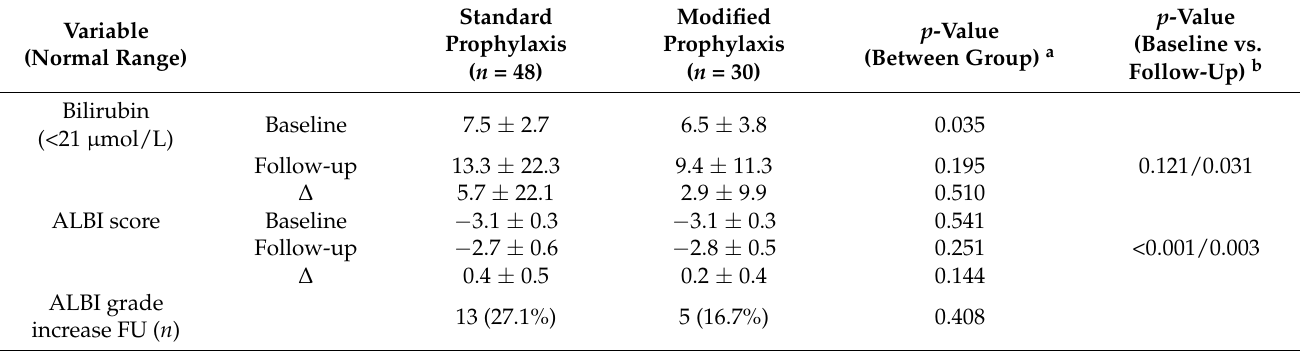
Table 2. Laboratory parameters at baseline and follow-up (Part I; Part II see Supplementary Material Table